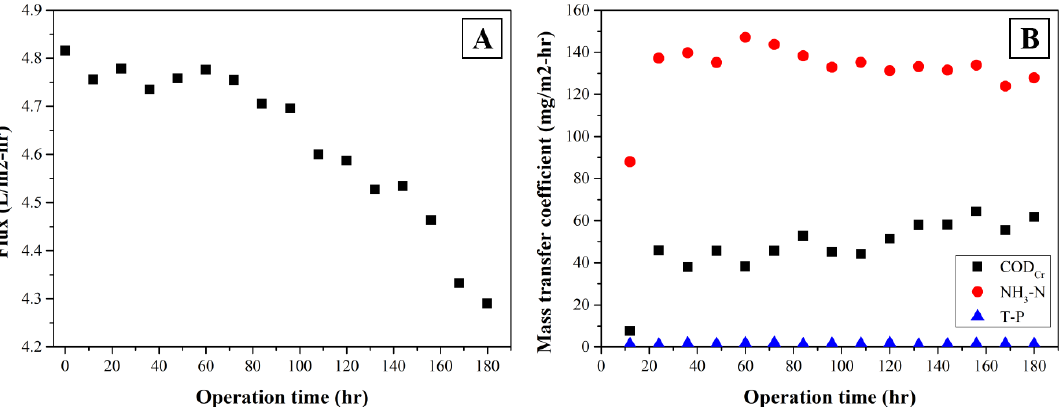
Figure 5. Variation of permeate flux ( A ) and mass transfer coefficients ( B ) in long-term operation.